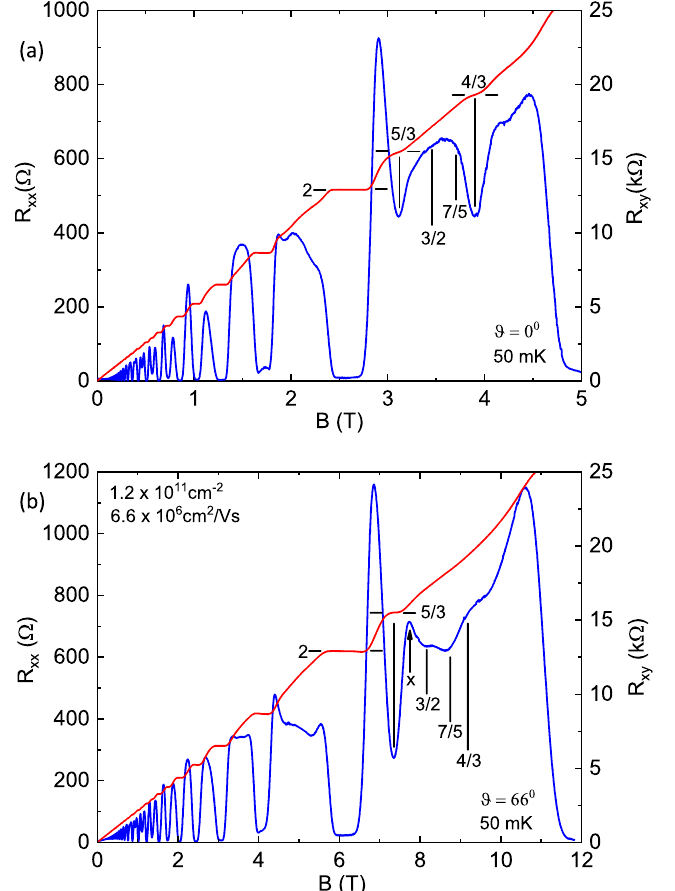
Figure 5. The diagonal and Hall resistances versus the magnetic field in a GaAs/AlGaAs heterostructure in the low mobility, low density condition. The diagonal resistance ( R xx ) and Hall resistance ( R xy ) are shown with some marked Integral (I) and Fractional (F) Quantized Hall Effects (QHE). ( a ) The R xx - and R xy - vs B at a tilt angle θ = 0 0 , where the sample normal is parallel to the magnetic field, i.e., θ = 0 0 . ( b ) The results at a tilt angle θ = 66 0